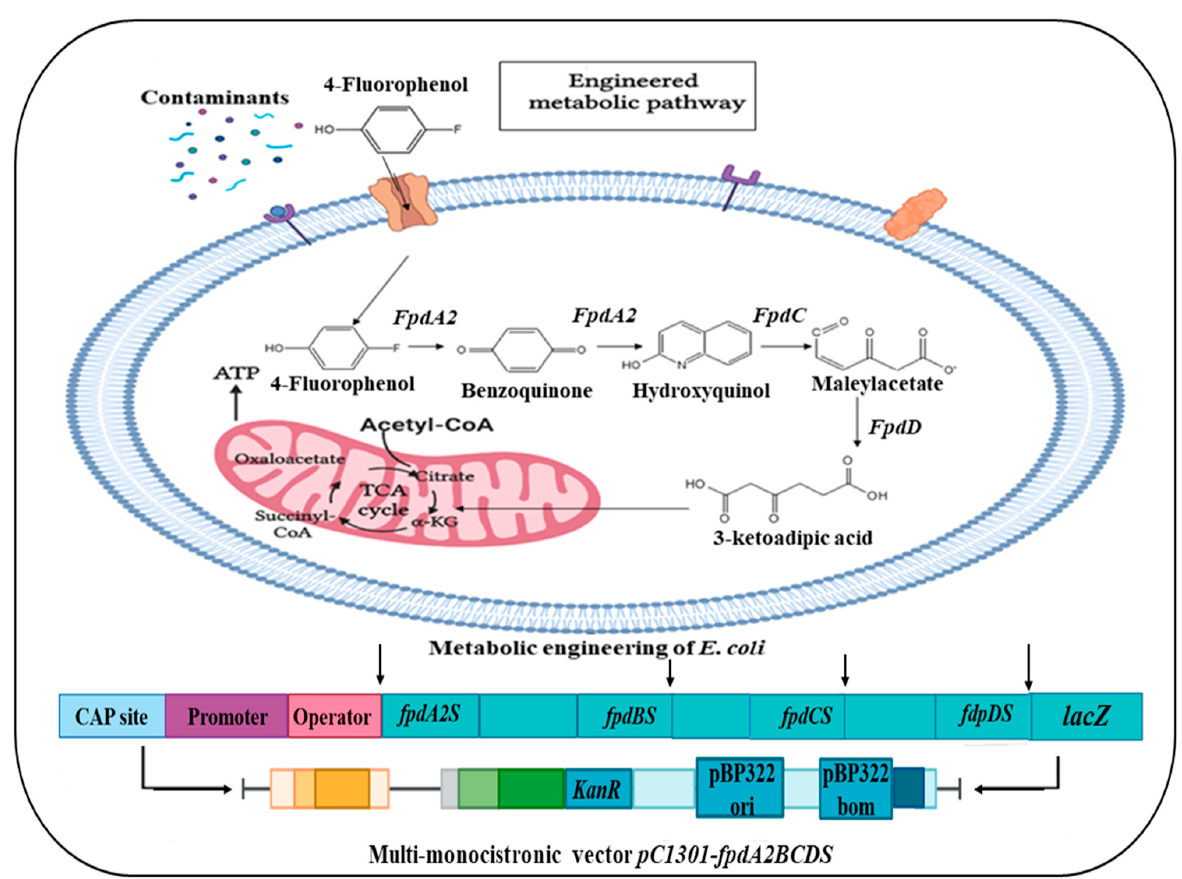
Figure 5. An illustration of metabolic engineering carried out in E. coli strain to enhance the degradation of 4-fluorophenol. Here, four genes from Arthrobacter sp. IF1 ( fpdA2 , fpdB , fpdC , and fpdD ) were synthesized, validated, and then integrated via a multi-monocistronic carrier to generate transgenic E. coli strain [185].